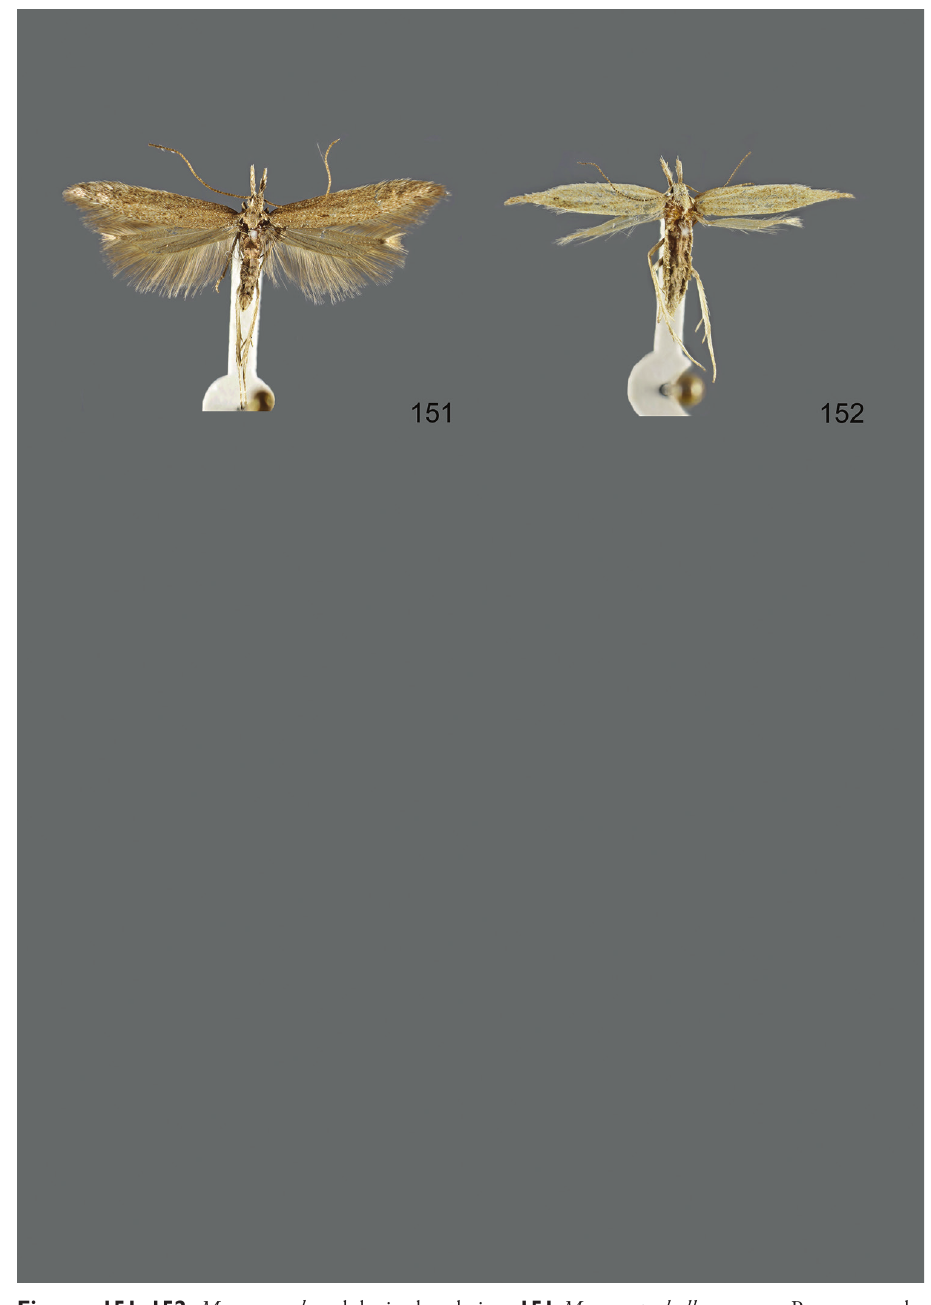
Figures 151–152. Megacraspedus adults in dorsal view. 151 M. armatophallus sp. n. – Paratype, male, Afghanistan (LNK) 152 M. armatophallus sp. n. – Paratype, female, Afghanistan